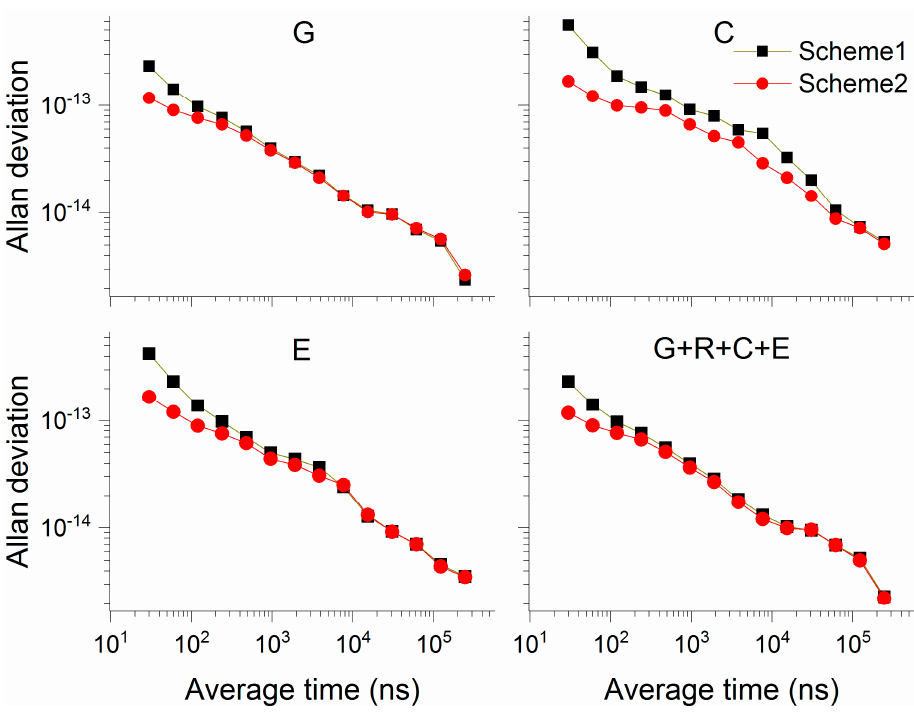
Figure 14. Allan deviation of scheme1 and scheme2 on PT11-NTSC with single-system and multi-GNSS models using COD products.